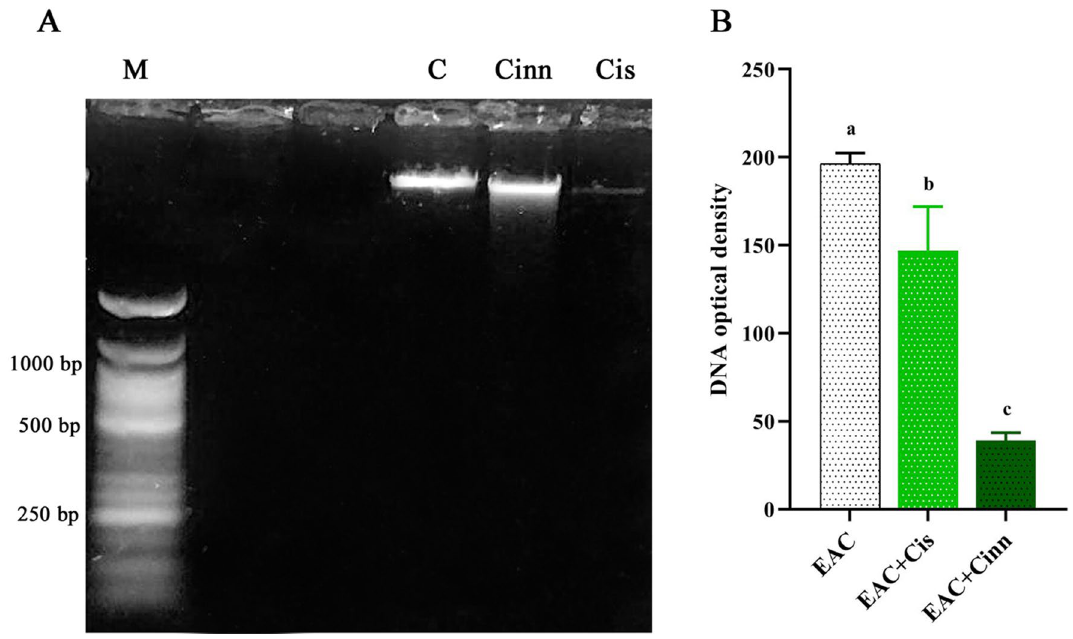
Figure 8. A representative photograph of agarose gel electrophoresis (1.8% ethidium bromide-stained) show the antitumor effect of cinnamon essential oil (Cinn, 50 mg/kg b.wt/day, orally) on Ehrlich ascites carcinoma (EAC) after 12 days of the treatments ( A ). Statistical data were shown as mean ± SD, n = 3, ( B ). Significant differences ( P < 0.05) between groups were shown by different letters. Cis, cisplatin (2 mg/kg b.wt,